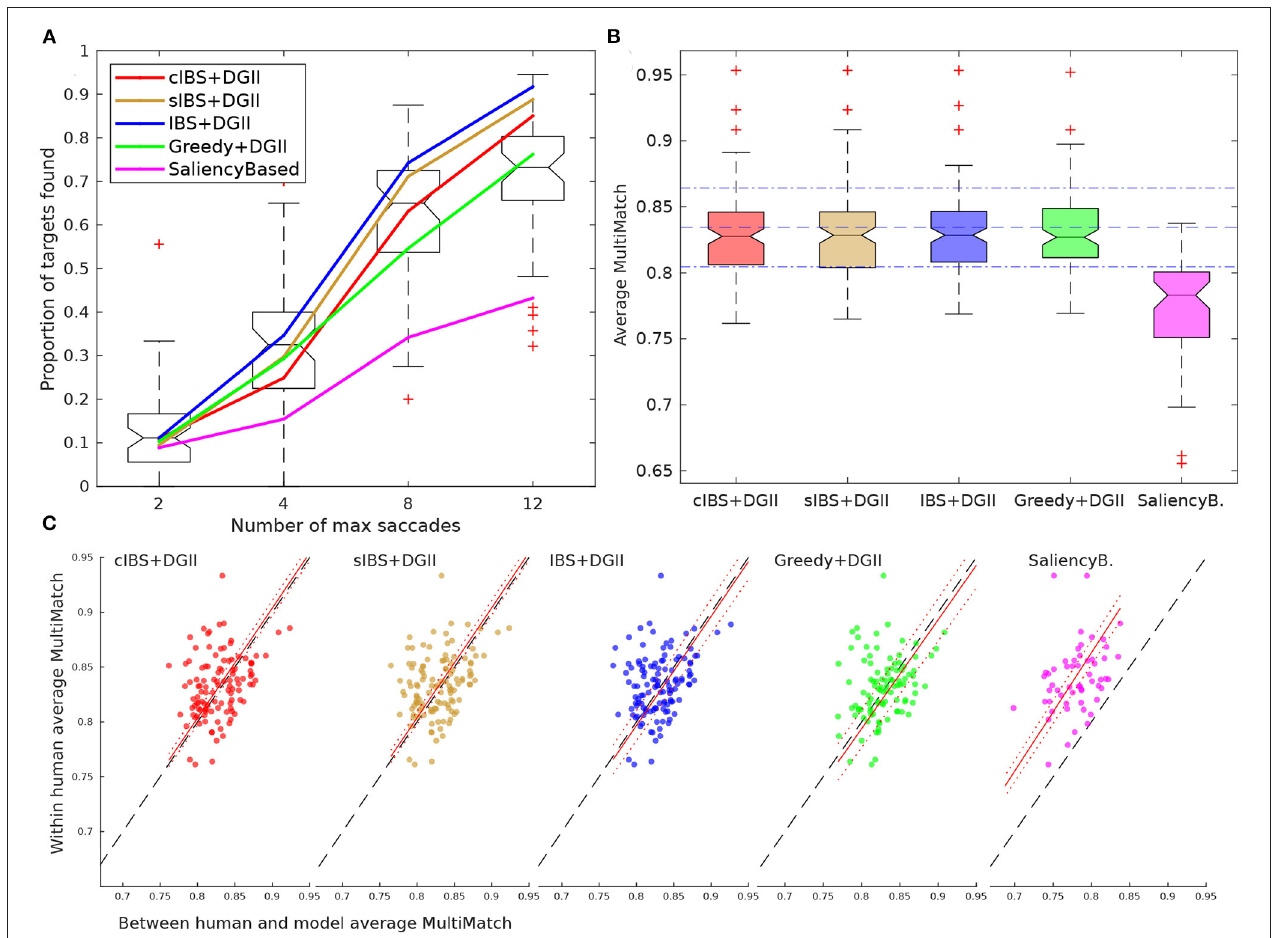
FIGURE 4 | Searcher strategy. (A) Proportion of targets found for each threshold that we considered. Human behavior is presented as a boxplot. The performance achieved by the models using different search strategies and DeepGazeII (DGII) as a prior is presented as curves. (B) Distribution of average MultiMatch similarity scores (vector, direction, position and length) for each strategy (higher is better). Blue horizontal lines represent the mean and standard deviation scores for humans (0.83 ± 0.02). (C) Mean within-human MultiMatch scores against the mean between human and the model’s MultiMatch scores. Linear regression with intercept = 0 was performed (red lines; see Table 1 ). Each dot represents an image of the dataset. Only trials where the target was found are considered in (B,C) for computing MultiMatch